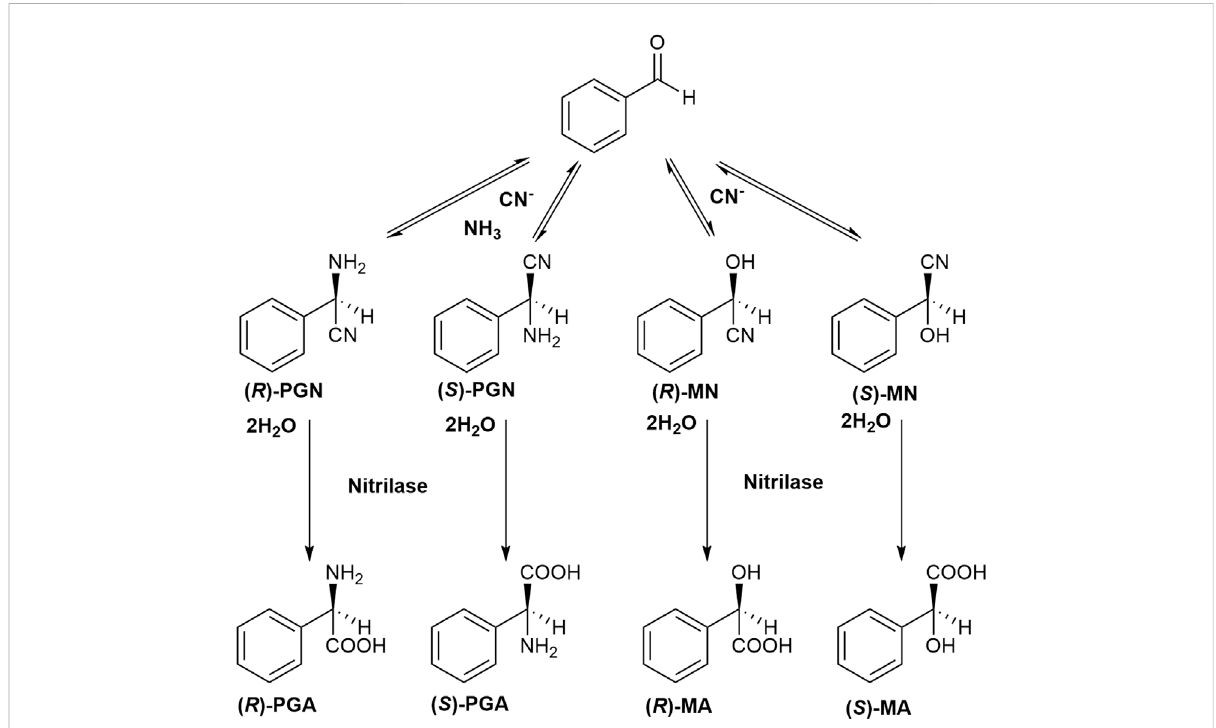
FIGURE 4 Formation of phenylglycinonitrile and mandelonitrile from benzaldehyde and cyanide (± ammonia) under the conditions of the Strecker synthesis and subsequent hydrolysis ofthe nitrilesby anitrilase. PGN phenylglycinonitrile, PGAphenylglycine, MNmandelonitrile, MA mandelic